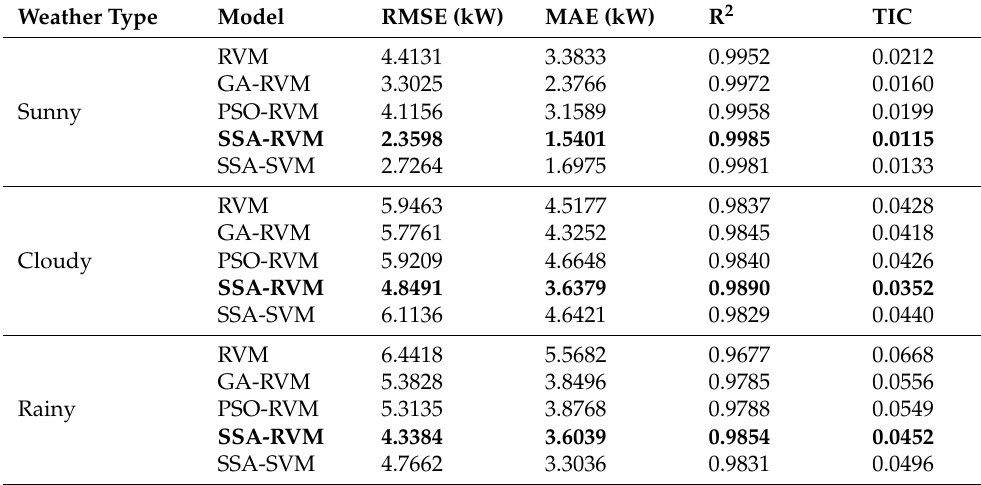
Table 5. Results of evaluation indexes of different methods with different weather types in winter.